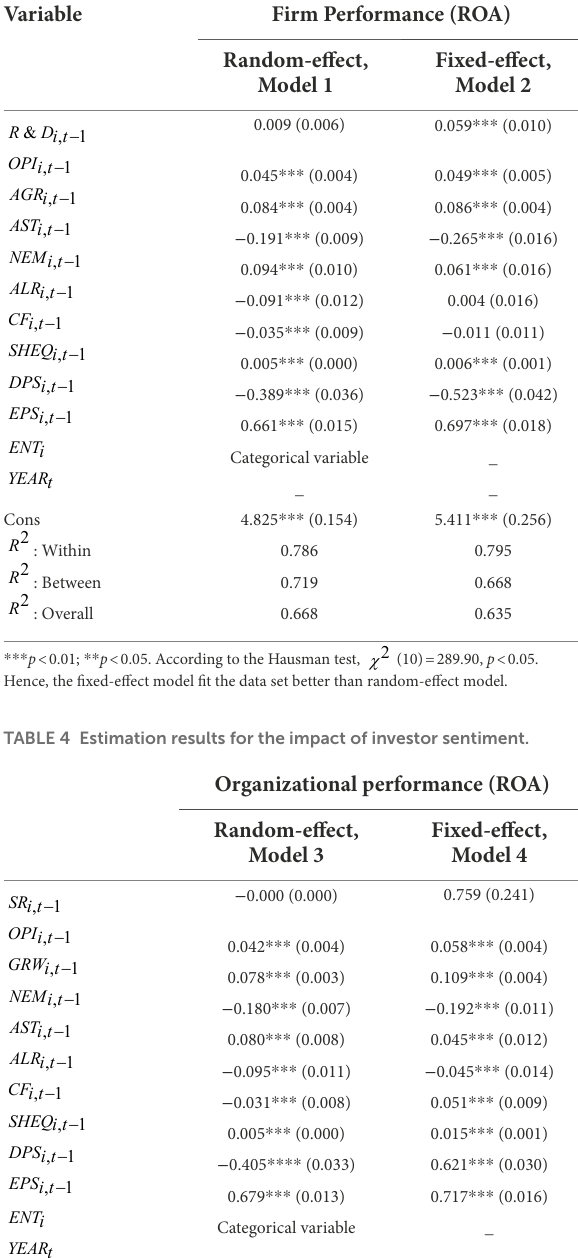
TABLE 3 Estimation results for the impact of innovation.